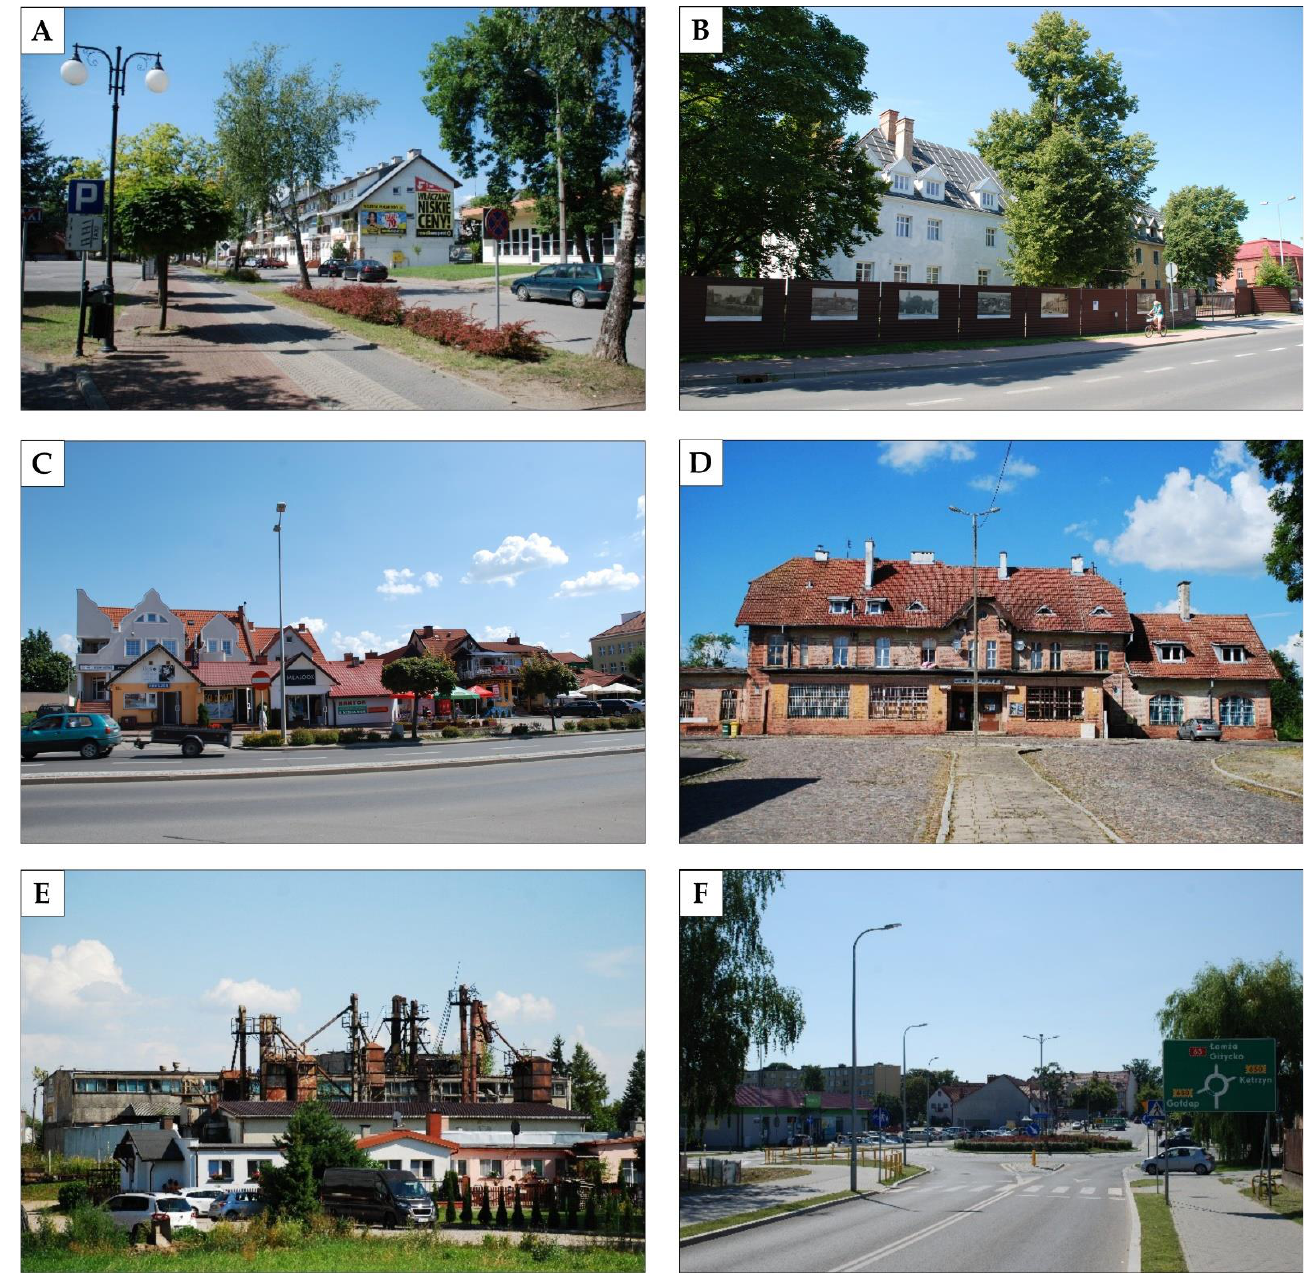
Figure 7. Examples of spatial chaos in Węgorzewo on an architectural and urban scale (status: September 2020). From left to right in the rows: ( A ). the lack of development on the northern side of Freedom Square (formerly Neuer Markt), ( B ). the castle and its fence from the side of Zamkowa Street, ( C ). ‘temporary’ commercial and food facilities at Zamkowa Street, ( D ). the building of the former Railway Station requiring revitalization, ( E ). the deteriorating infrastructure of the industrial district from the side of Jaracza Street, ( F ). chaotic service and municipal buildings from the Armii Krajowej Street side. Source: own photos.